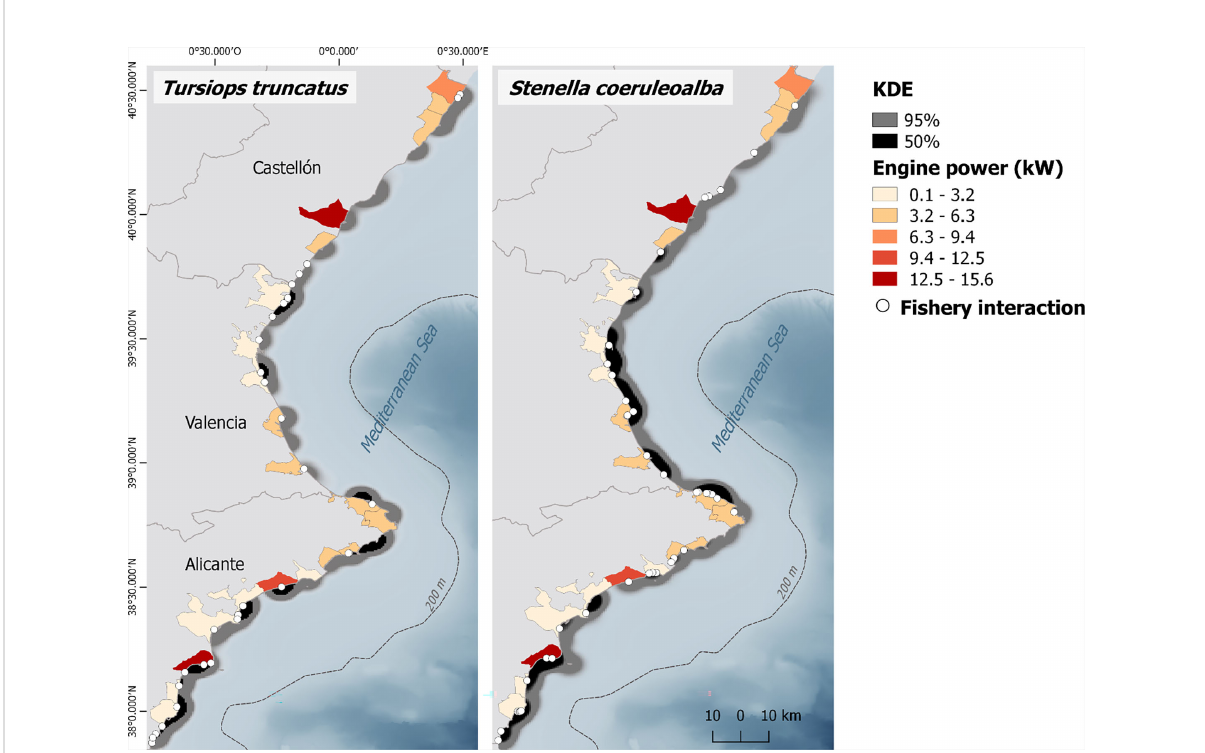
FIGURE 2 Kernel density estimations (KDE) of Tursiops truncatus (left) and Stenella coeruleoalba (right) stranding events from records of the Valencia region stranding network for the period 1990-2020, according to 5 × 5-km grid cells. The core stranding areas of both species (50% KDE) are represented. The legend inside the fi gure also shows the ports in fi ve strata representing the proportions of engine power (kW) of each fi shing port in relation to the total engine power of the Valencia region fi shing fl eet. Colored areas represent the municipality of the port. White circles show stranded individuals recorded with fi shery interaction signs. Additional details of the study area are shown in Figure